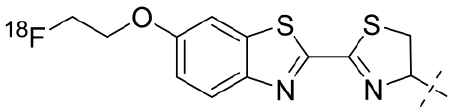
Figure 9. 18 F-labeled 2-cyanobenzothiazole ([ 18 F]-F-CBT)-label coupled to an N-terminal